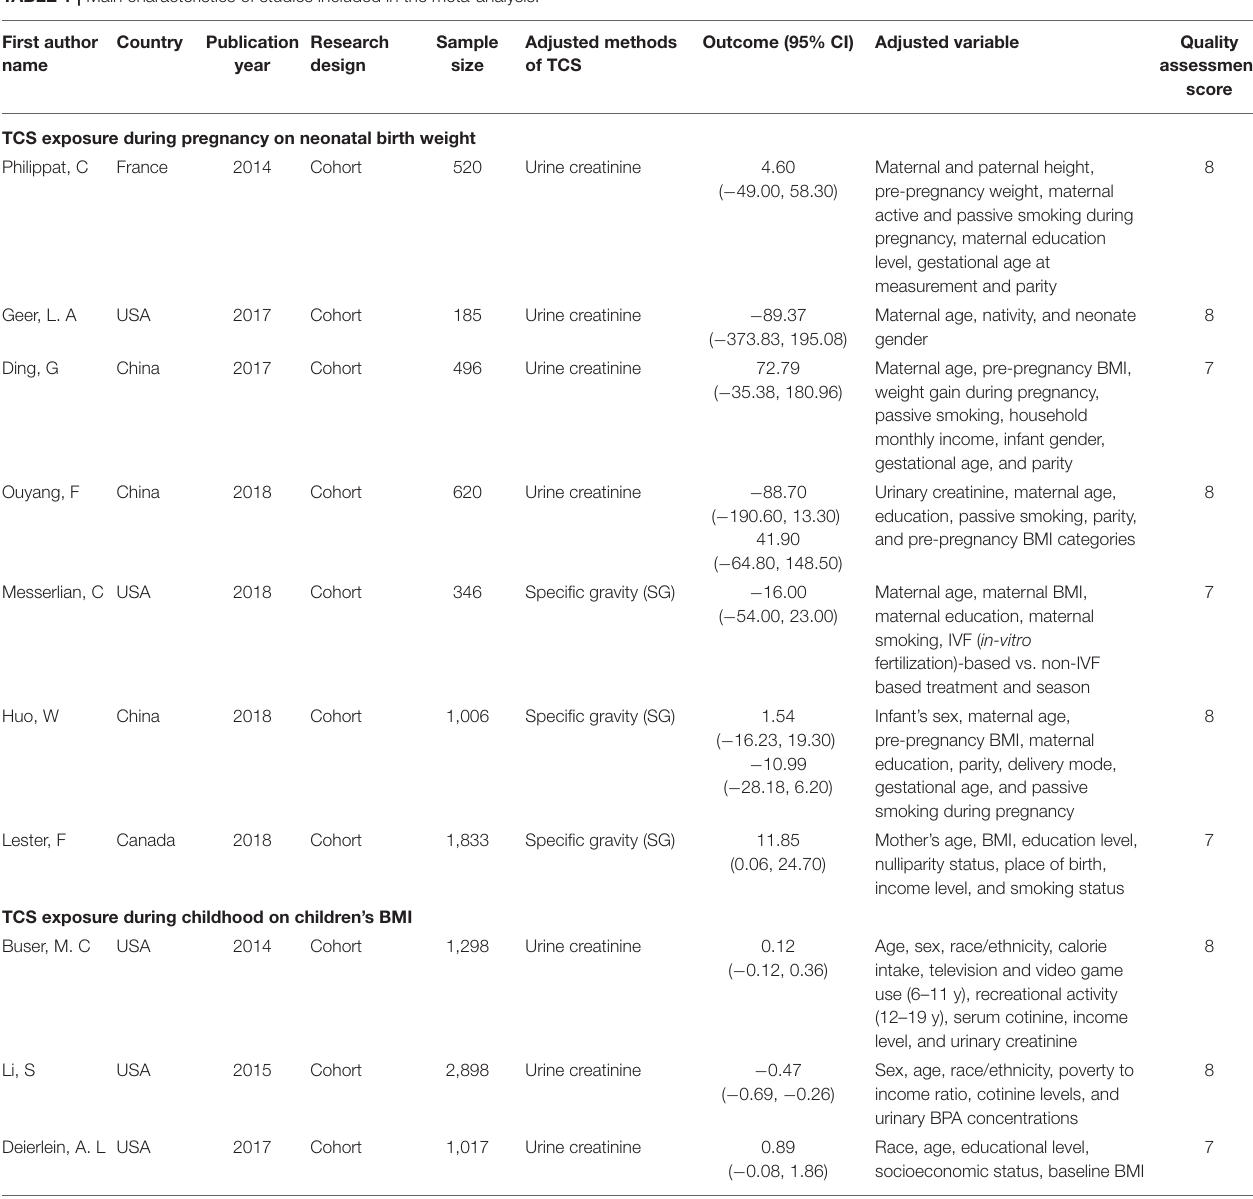
TABLE 1 | Main characteristics of studies included in the